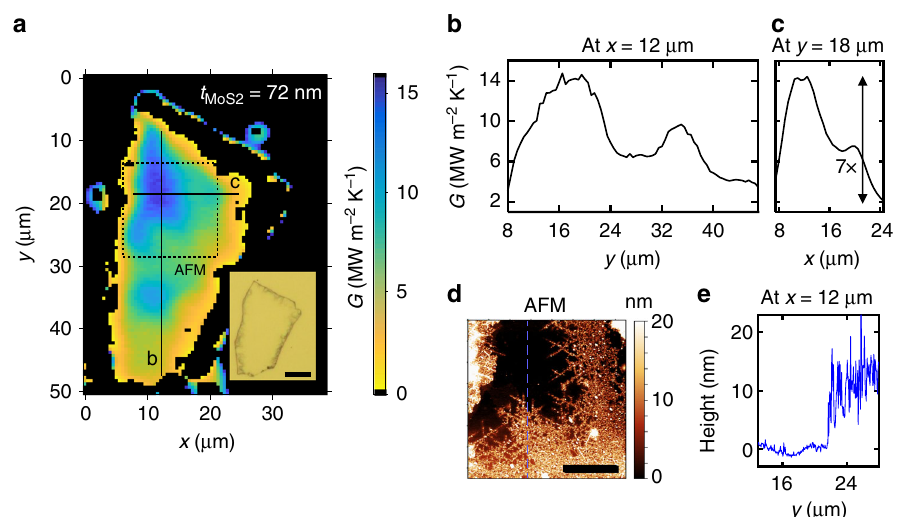
Fig. 4 Ex situ chemical lithiation experiments. a Thermal conductance map of a 72 nm thick single crystal MoS 2 fi lm lithiated using n -Butyllithium for 2 h. Inset shows an optical micrograph of the device, after coating with 81 nm thick Al layer (scale bar is 10 µ m). b Vertical line scan taken at x = 12 µ m, and c horizontal line scan taken at y = 18 µ m, extracted from the thermal conductance map along the solid lines marked in a . d AFM image of the region enclosed within the dashed box in a , showing a clear correlation between topography and thermal conductance. The smooth pristine region shows the highest thermal conductance, while the rough lithiated region is more thermally resistive. The scale bar is 5 µ m. e Height pro fi le extracted from the AFM image along the blue dashed line indicated in d at x = 12 µ (blue) vs. Li (red) participation. Figures 5d and e show displacement vectors for modes at 6.72 THz in 1T-Li 1 MoS 2 and 4.61 THz in 2H-Li 1 MoS 2 , respectively, revealing that Li-related modes are decoupled from the motion of Mo and S atoms.